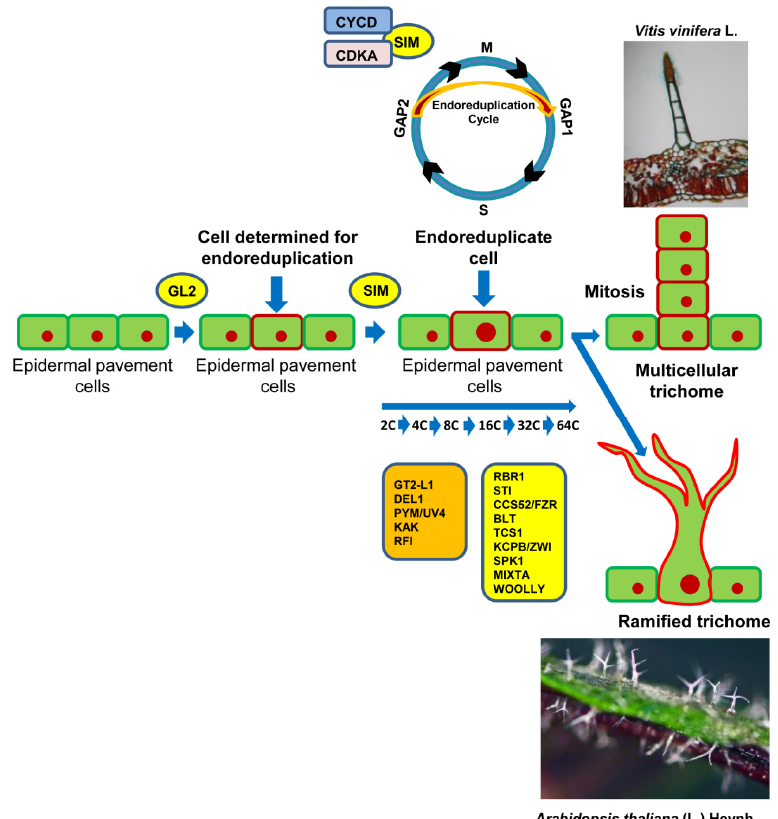
Figure 2. A simplified model for the di ff erentiation of multicellular and ramified trichomes. An epidermal pavement cell activated by GLABRA2 ( GL2 ) becomes determined for trichome initiation (red cell wall). The SIAMESE ( SIM ) gene promotes the endoreduplication cycle (see also Figure 1). SIM interacts with D-type cyclin-CYCLIN-DEPENDENT KINASE A (CYCD-CDKA) complexes, which normally operate at the G1 / S and G2 / M transitions, to suppress entry into phase M. The nuclear DNA content increases from 2C to 64C. The endoreduplicate cell can follow two fates, also in relation to the species: entering the mitosis process, originating a multicellular trichome as in the grape ( Vitis vinifera L.), or promoting the development of branched trichomes, as in Arabidopsis thaliana (L.) Heynh. In the orange box are indicated some negative regulators involved in the development of complex trichomes: GT2-LIKE1 trihelix ( GT2-L1 ), DP-E2F-Like1 ( DEL1 ), KAKTUS ( KAK ), POLYCHOME // UV-INSENSITIVE4 ( PYM / UVI4 ), and RASTAFARI ( RFI ). By contrast, in the yellow box are indicated some positive regulators: RETINOBLASTOMARELATED1 ( RBR1 ), STICHEL ( STI ), CELLCYCLESWITCH52A2 / FIZZY-RELATED1 ( CCS52A2 ) / FZR1 , CCS52A1 / FZR2 , BRACHLESS TRICHOME ( BLT ), TRICHOME CELL SHAPE 1 ( TCS1 ), KINESIN-LIKE CALMODULIN-BINDING PROTEIN / ZWICHEL ( KCBP / ZWI ), BRACHLESS TRICHOME ( BLT ), SPIKE1 ( SPK1 ), MIXTA and WOOLLY ( WO ). (See the text for the specific activity of each gene on cell cycle regulation). G1: Gap 1; G2: Gap2; M: mitosis, S: DNA synthesis.